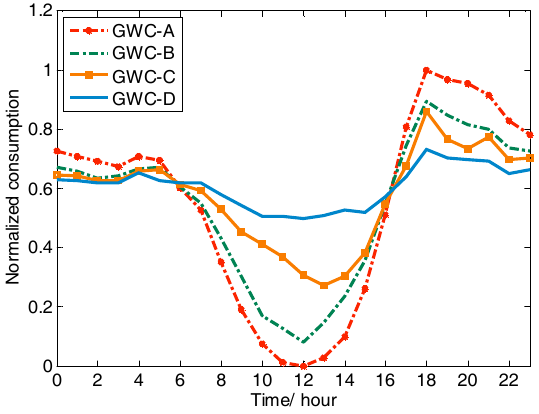
Figure 4. An example of TNLPs in four GWCs.